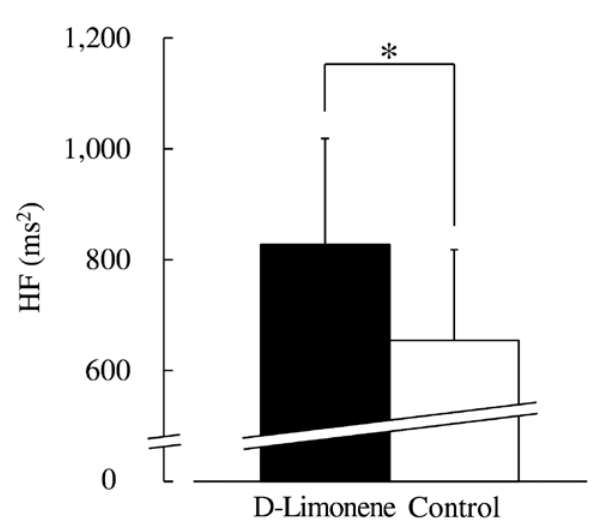
Fig. 2 - Comparison of high-frequency power levels of heart rate vari- ability during olfactory stimulation with D-Limonene or con- trol (air). Data are expressed as mean ± SE; n = 13. * P < 0.05 by paired t -test.